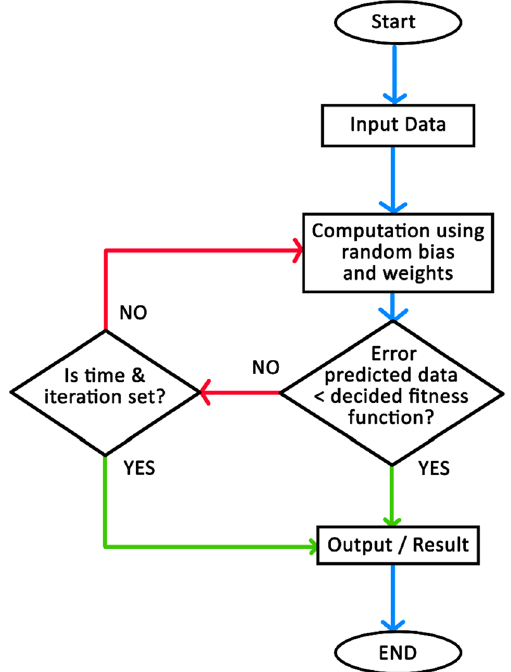
Fig. 1 The flow of the standard ANN